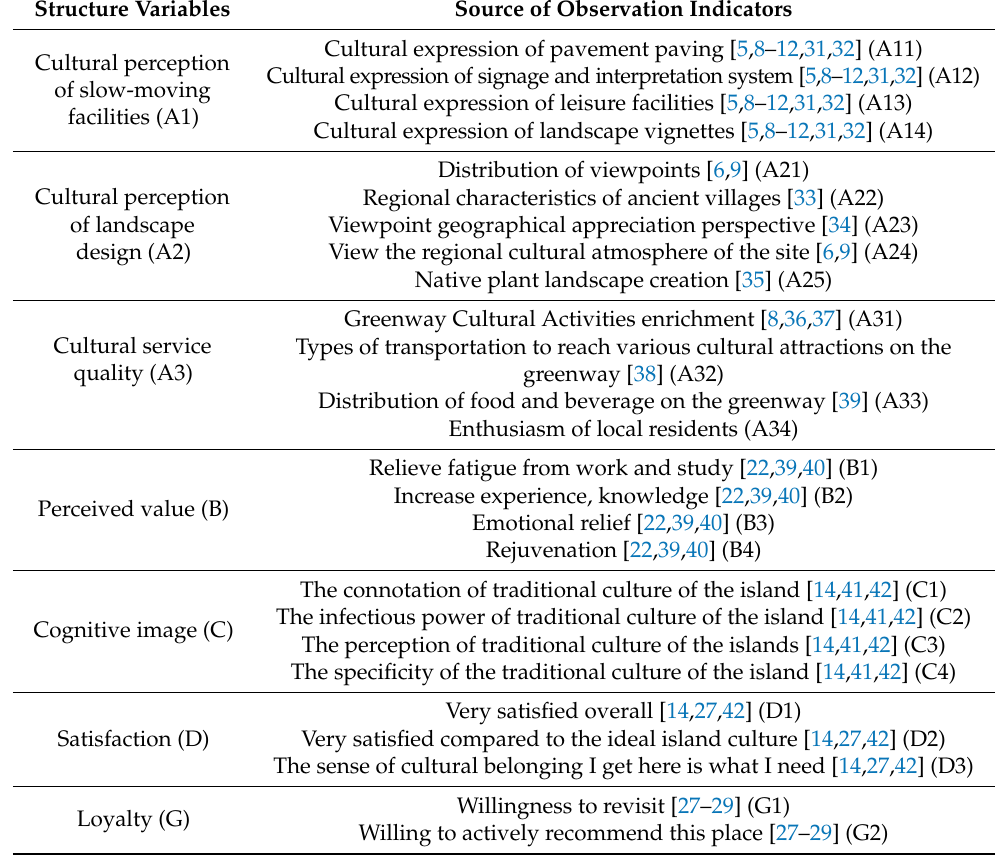
Table 1. Measurement scale question